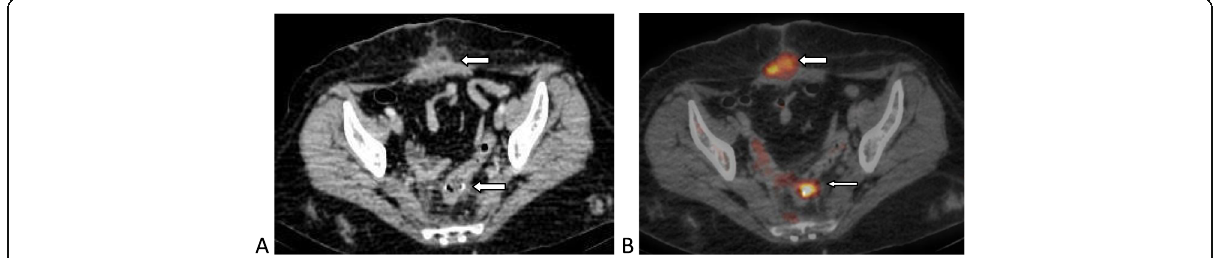
Fig. 2 A 64-year-old female patient who underwent surgical resection for pathologically proven colonic adenocarcinoma, presented with an elevated tumor marker. a Axial post-contrast CT image showing early post-operative enhancing scar and minimal thickening at the anastomotic site (arrows), b axial fused PET – CT image showing corresponding metabolic activity in the base line PET – CT